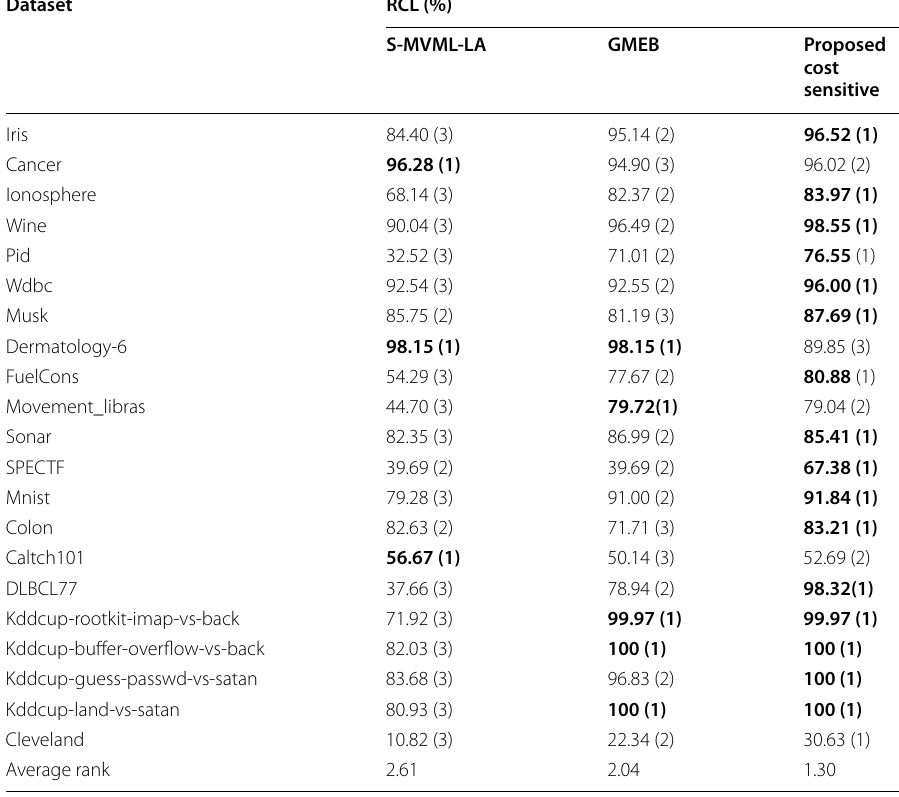
The numbers in bold are the best accuracies achieved on the dataset